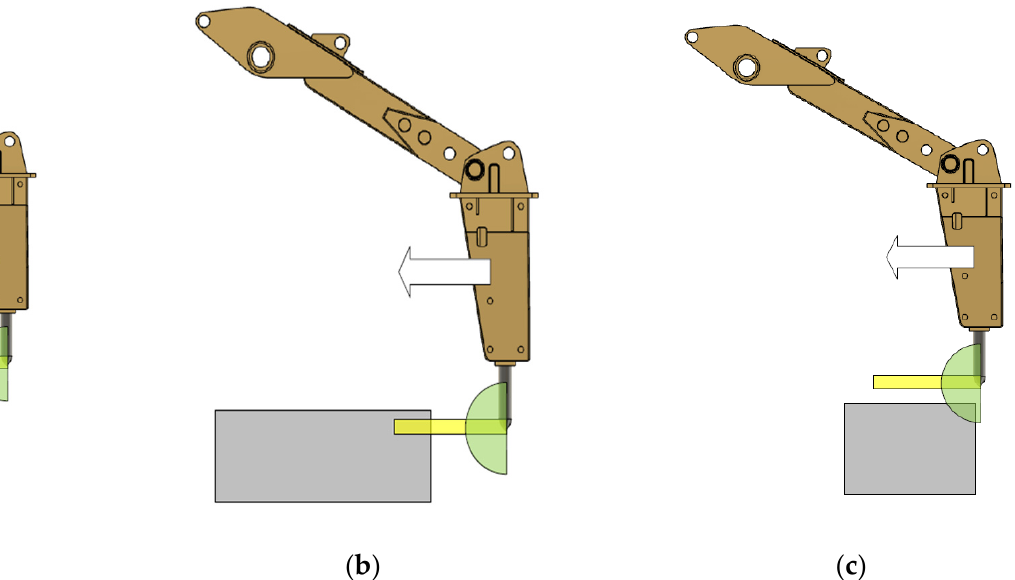
Figure 11. ( a ) Rectangular cuboid and semi-sphere regions without intersection with a collision point cloud. ( b ) Rectangular cuboid intersects the collision point cloud. ( c ) Semi-sphere region in- tersects the collision point cloud and the cuboid does not. The yellow rectangle represents the cuboid. The green semi-circle represents the semi-sphere. The white arrow corresponds to the hammer direction.